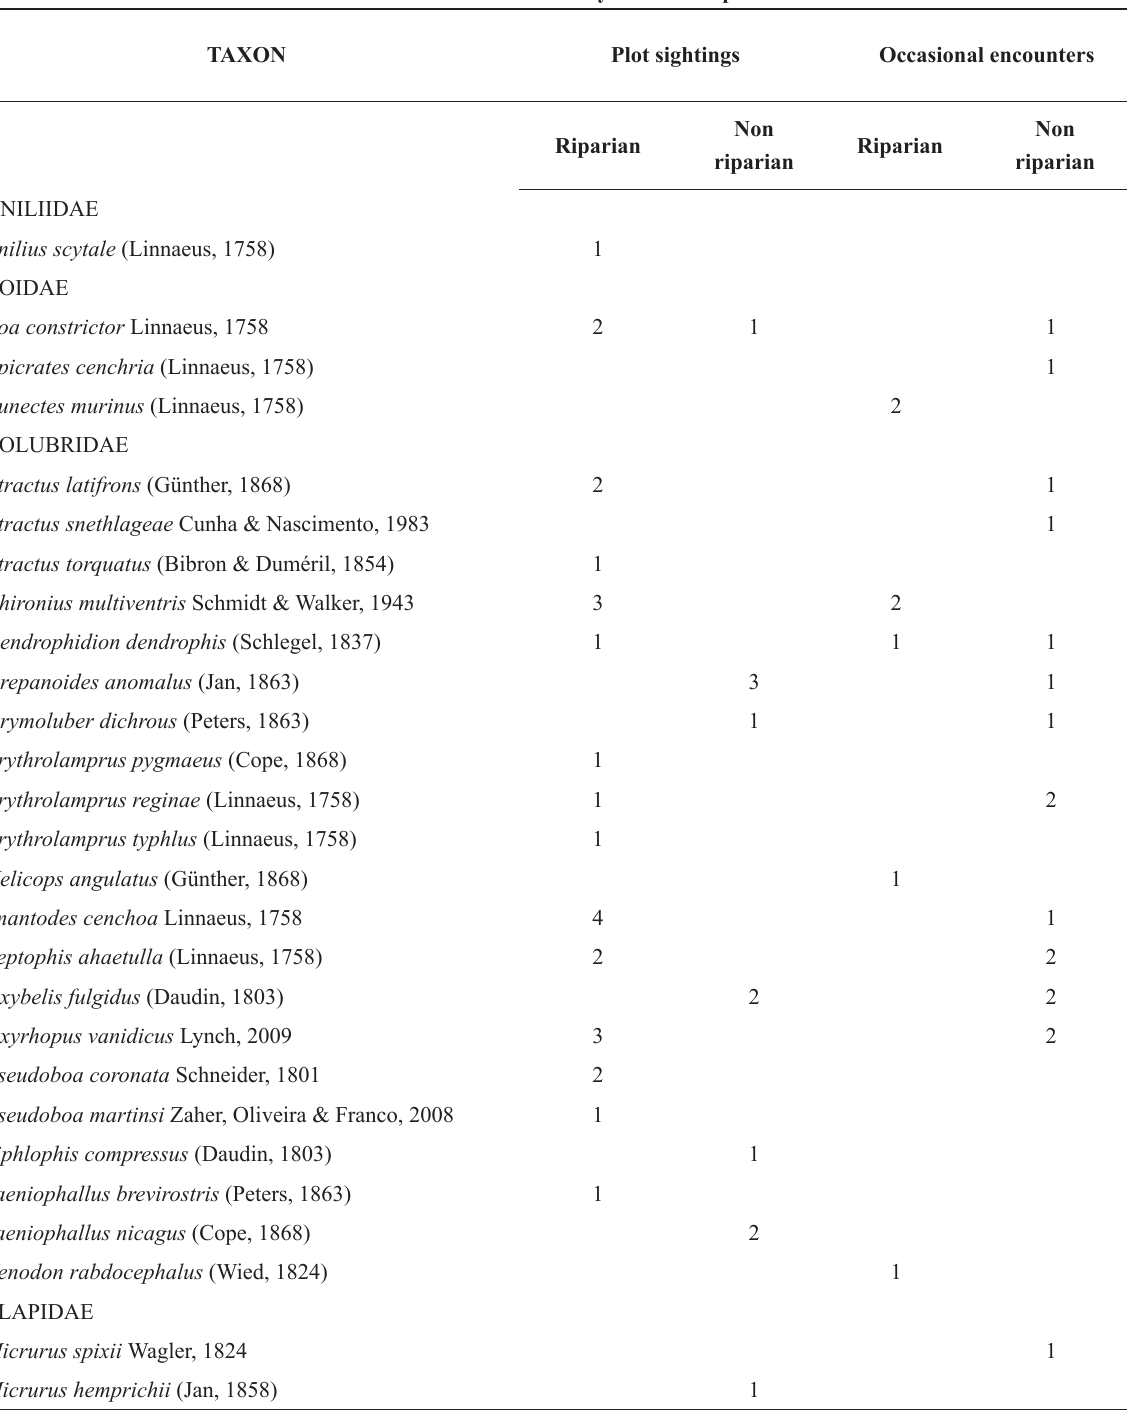
TABLE I Species recorded and their respective abundances in an area of upland forest in Central Amazonia between July 2015 and April 2017. TAXON Plot sightings Occasional encounters